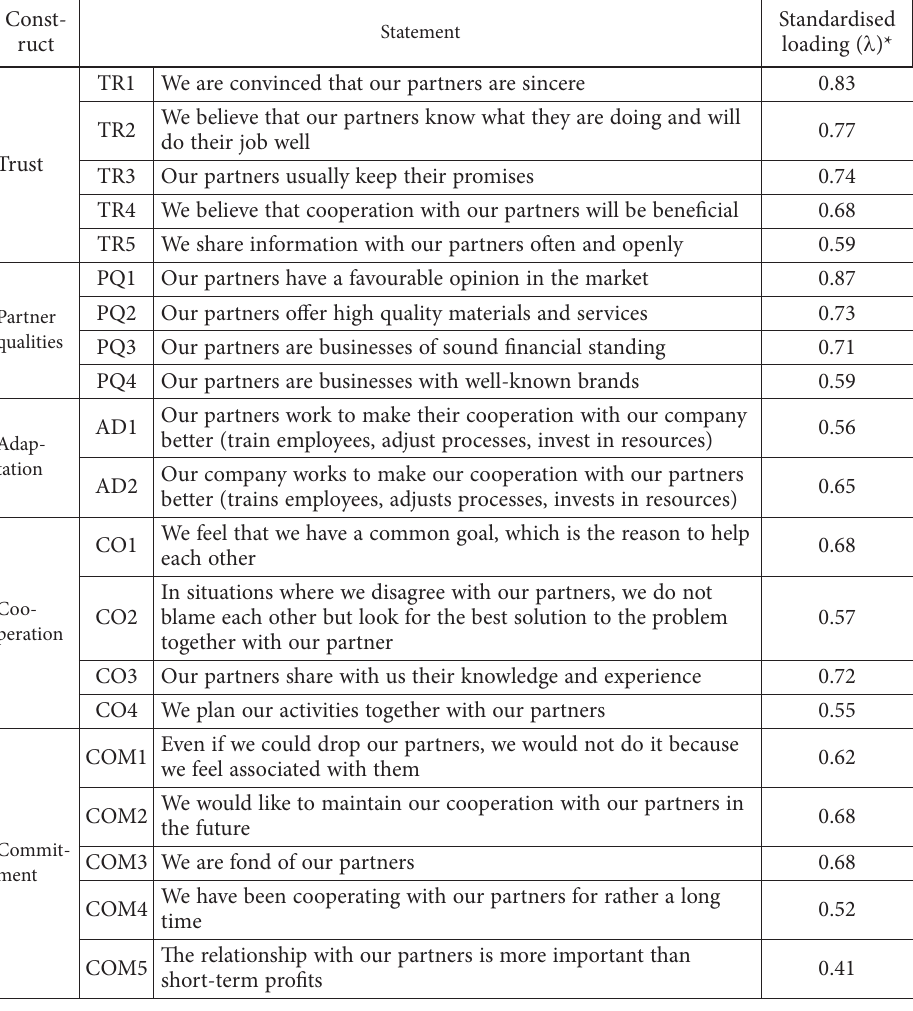
Table 1. Confirmatory factor analysis